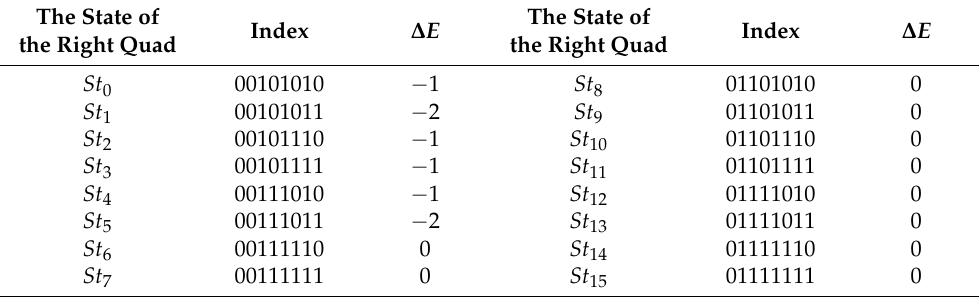
Table 2. The Euler number increment of a voxel pattern whose left quad is St 7 . The State